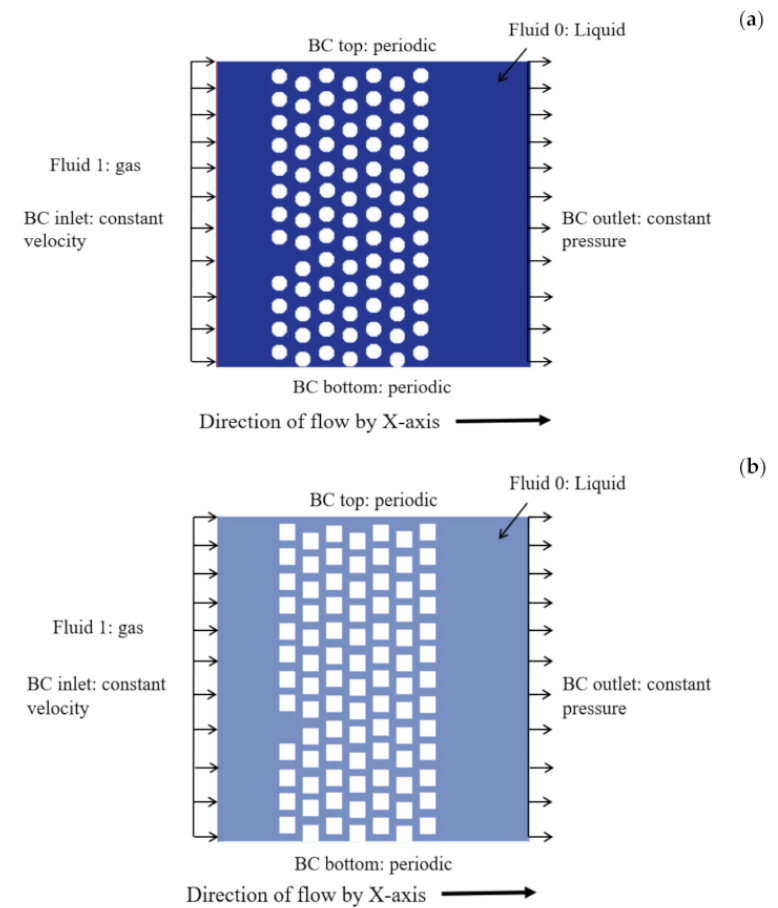
Figure 4. ( a ) Initial and boundary conditions for the circular pore domain (white circles are pores with radius = 10 lu); ( b ) Initial and boundary conditions for the rectangular pore domain (white squares are pores with side = 20